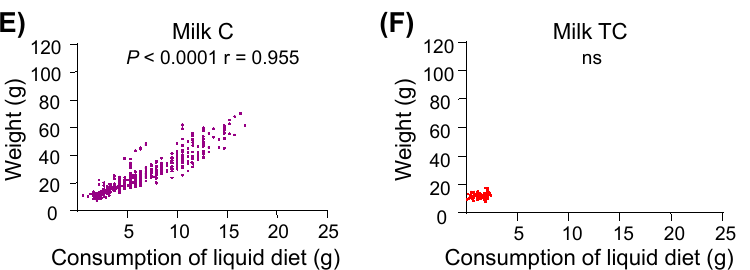
Figure 4. The correlation between body weight and daily milk consumption in the tree shrew pups fed with different milks. The correlation between body weight and daily milk consumption in pups (for pups fed with maternal milk ( A ), postnatal days 1–30; for pups fed with artificial milk ( B ), including milk A ( C ), milk B ( D ), milk C ( E ), and milk TC ( F ), postnatal days 1–24). A p value < 0.05 was considered as statistically significant; and ns, not significant.